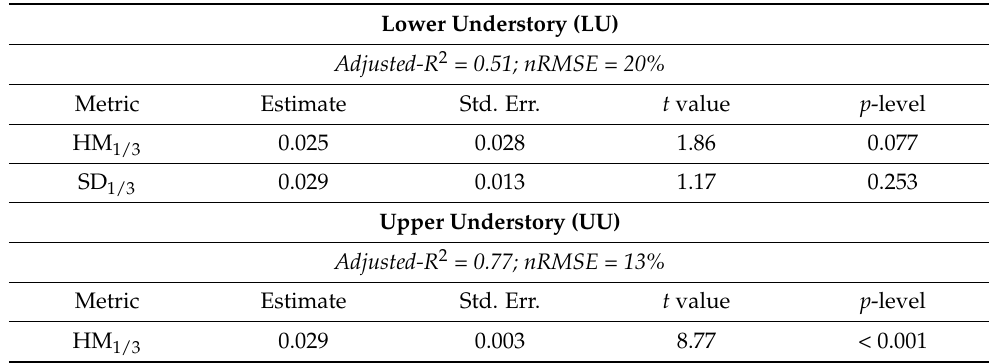
Table 2. Leave-one-out cross-validation results obtained for the prediction of understory vegetation density in the two considered layers (LU and UU).